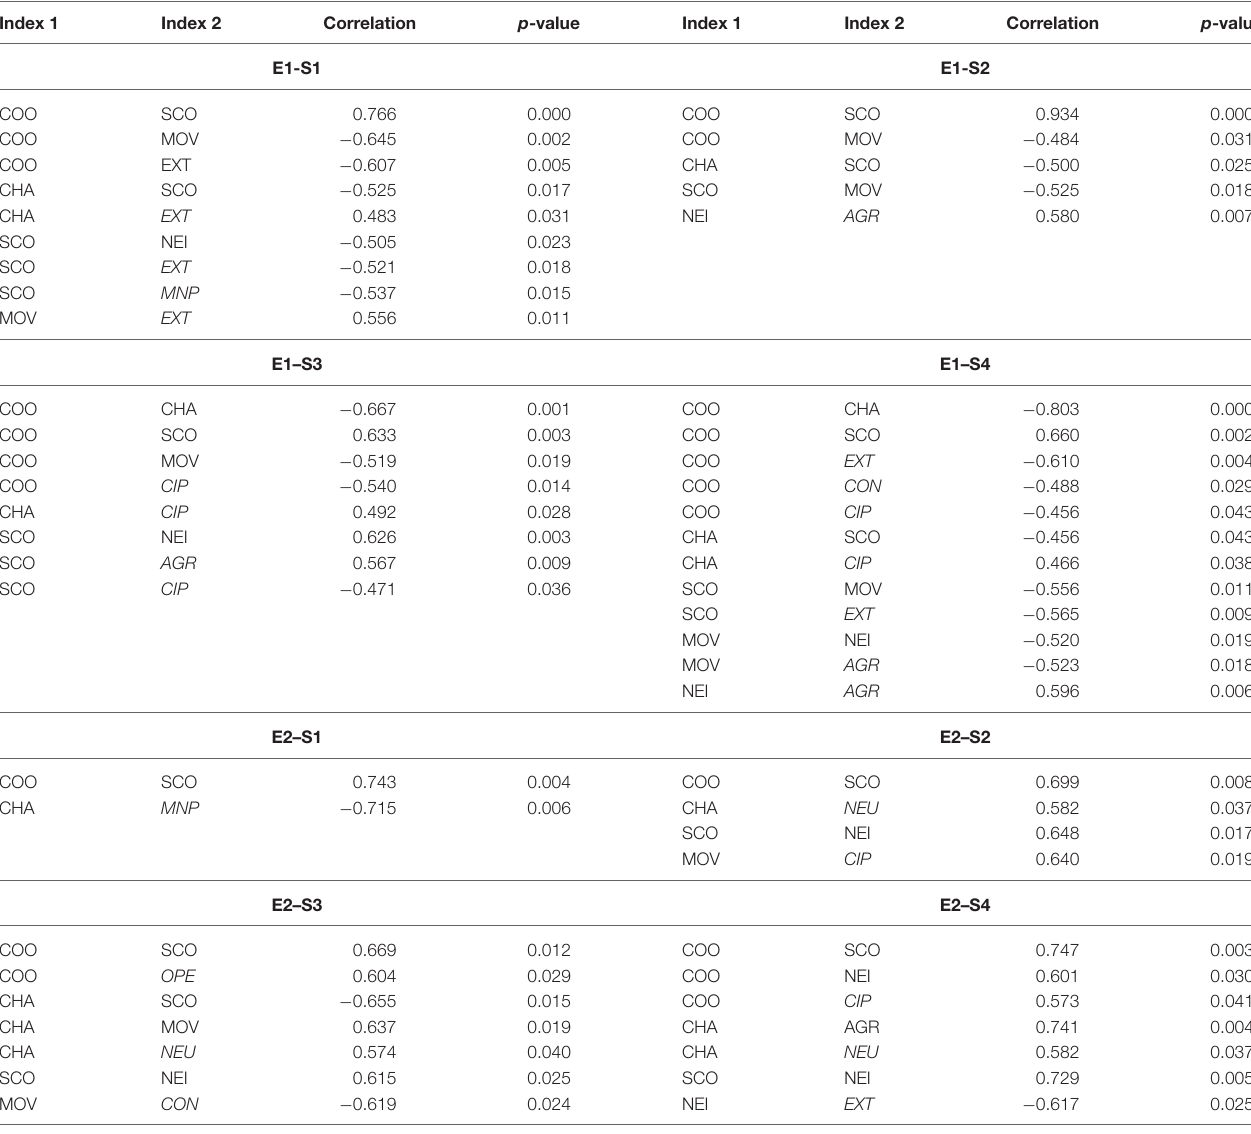
TABLE 2 | Results of correlation analyses of indices (Spearman’ s rank correlation